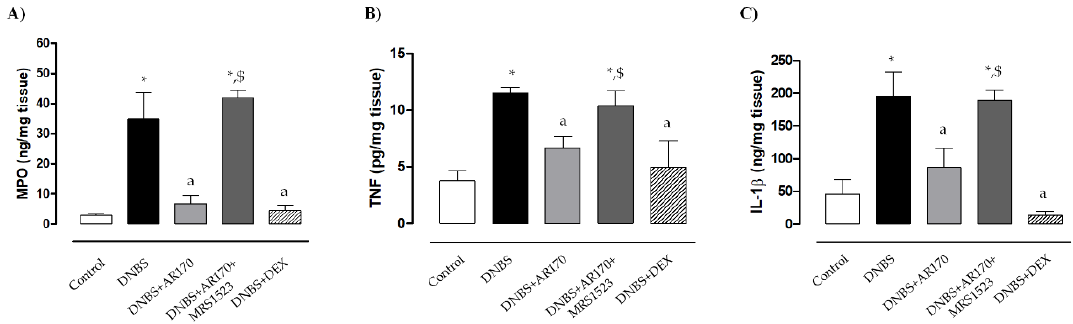
Figure 4. Myeloperoxidase (MPO) ( A ), tumor necrosis factor (TNF) ( B ), and interleukin 1 β (IL-1 β ) levels ( C ) in colonic tissue in the control rats and in animals treated with DNBS alone or in combination with AR170 (3 mg / kg / day), AR170 plus MRS1523 (8 mg / kg / day), or DEX (1 mg / kg / day). Each column represents the mean ±S.E.M. ( n = 8–10). * p < 0.05, significant difference vs. control rats; a p < 0.05, significant difference vs. DNBS group; $ p < 0.05, significant difference vs. the DNBS + AR170 group.